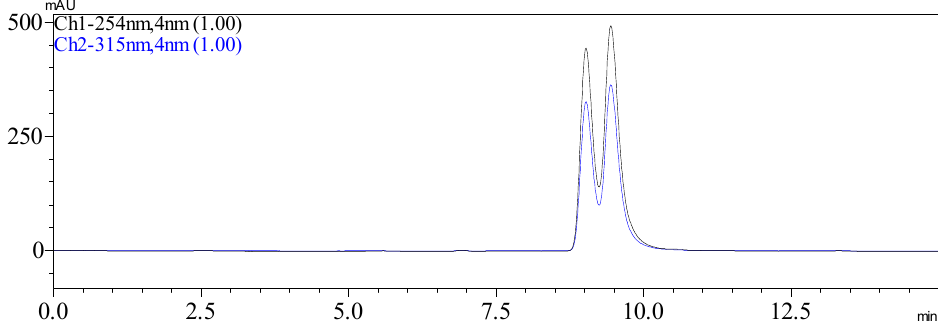
Figure 3. HPLC chromatogram of (±)-6-hydroxy-kielcorin ( 1 ) on a chiral column.